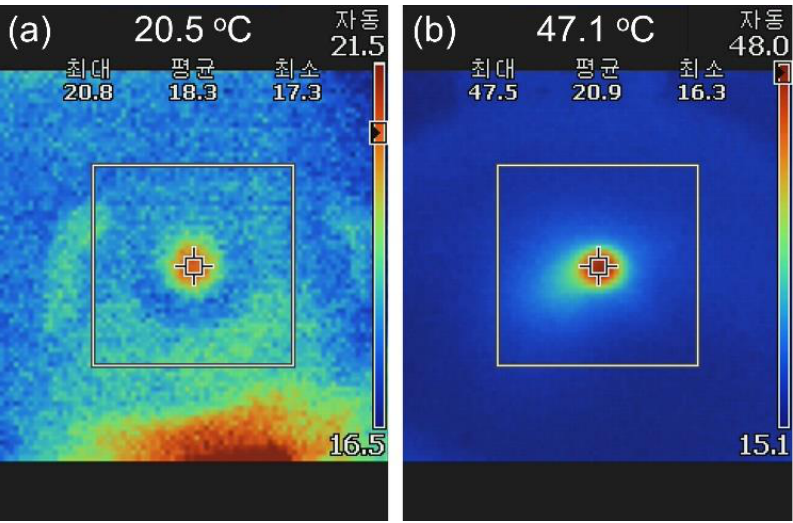
Figure 6. Infrared camera images of the nanofibers ( a ) without GNRs and ( b ) with GNRs.